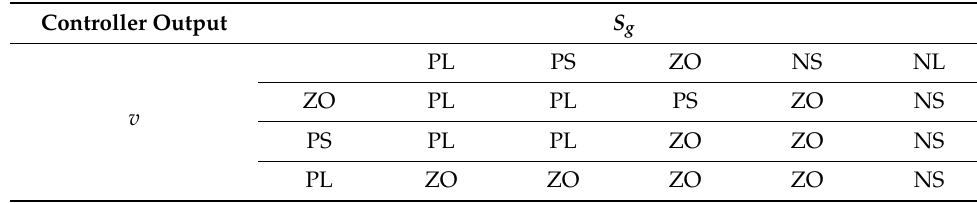
Table 6. Fuzzy rule base (with user’s posture; f f = L, f d = L).